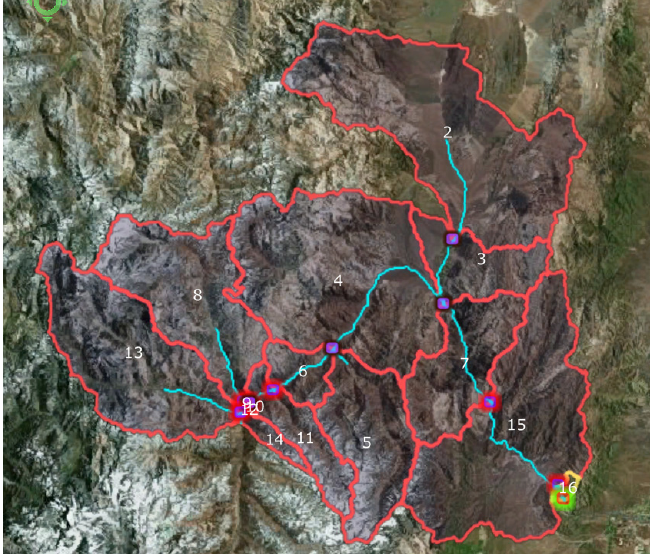
Figure 10. The Maps option of SWAT ‐ CUP can be used to see details of the watershed under investigation, such as dams, wrongly placed outlets, glaciers, high agricultural areas, etc.